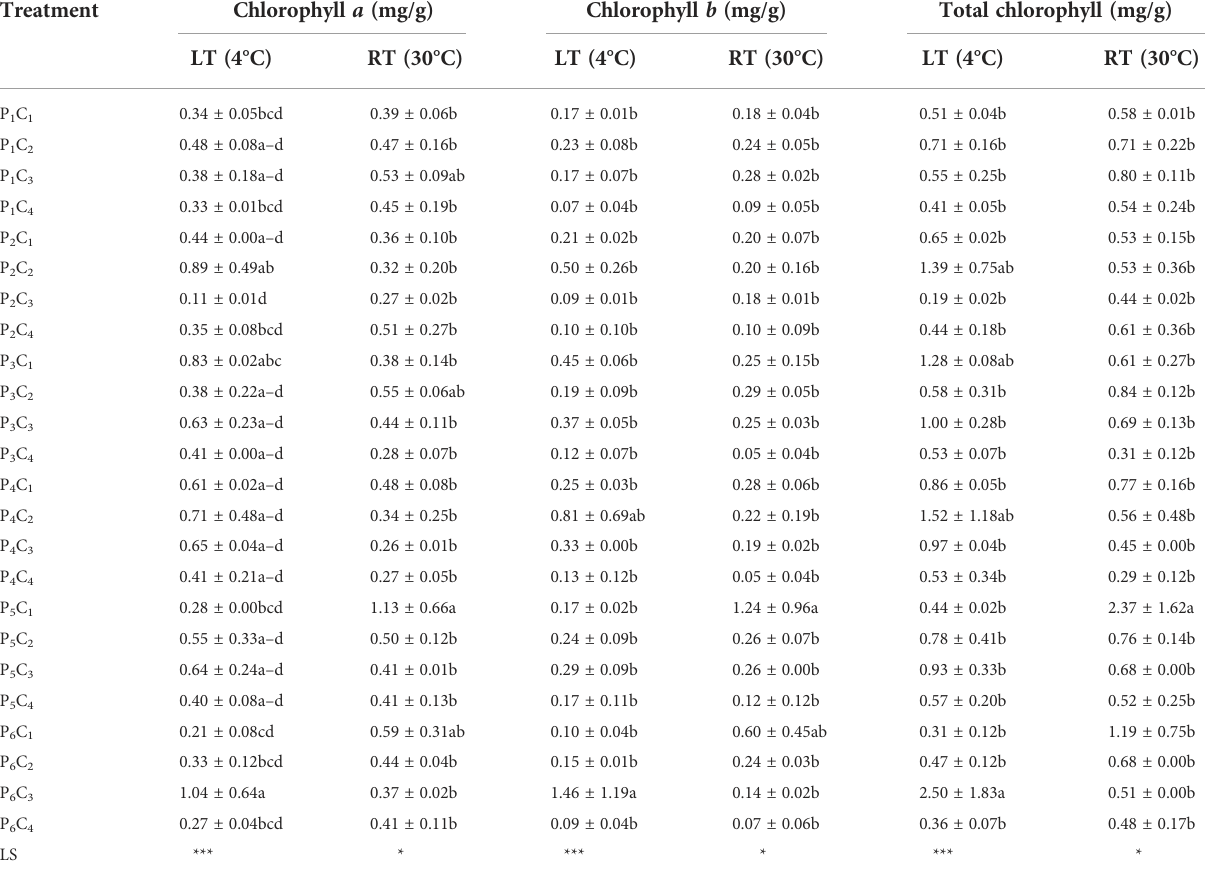
Numeric values (±) are standard deviation, and letters in the same row are signi fi cant differences. P 1 and C 1 , control; P 2 and P 3 , perforated and non-perforated polyethylene (PPE and NPE, respectively); P 4 and P 5 , perforated and non-perforated polypropylene (PPP and NPP, respectively); P 6 , brown paper (BP); C 2 , NaOCl; C 3 , KMS; C 4 , blanching. *p < 0.05, **p < 0.01, ***p <